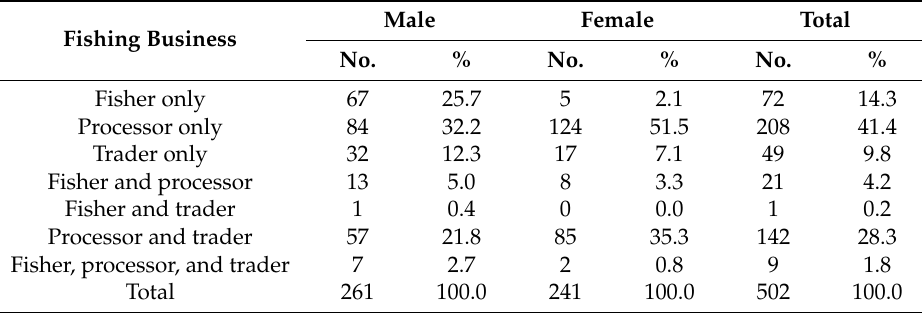
Table 2. Occupation of fisher folks in Mangochi and Salima